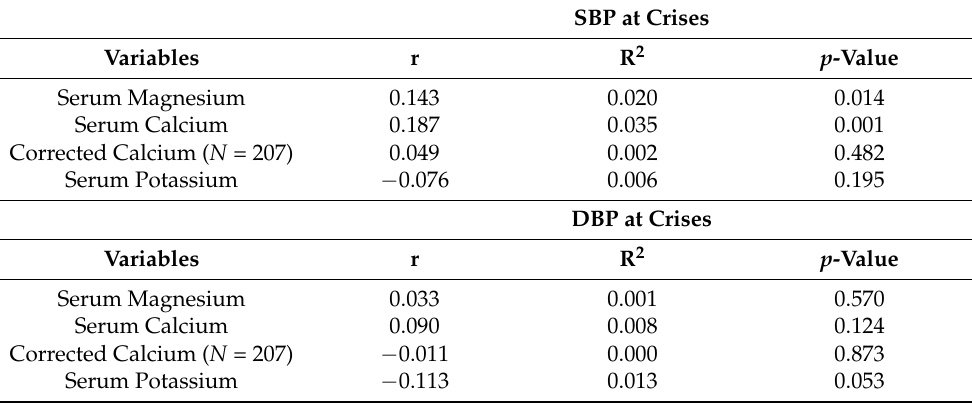
Table 2. Association of serum magnesium and other electrolytes with SBP at crises or at crises ( N = 293).